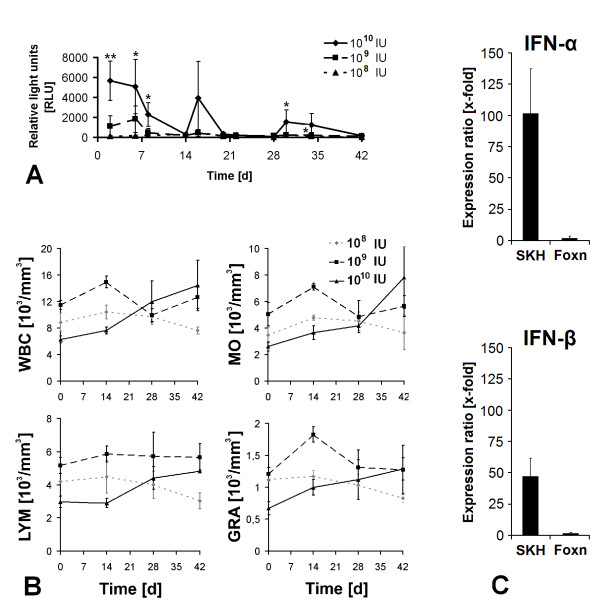
Investigation of adenovirus induced immune reaction in vivo. (A) Quantitative GFP fluorescence and (B) numbers of leucocytes (WBC), granulocytes (GRA), lymphocytes (LYM) and monocytes (MO) in immunocompetent, hairless mice (SKH-1h/r) at timepoints of 14, 28 and 42 days after intradermal injection of 108 - 1010 IU Ad-GFP. (C) RT-PCR analysis of IFN-α and IFN-β expression 48 h after intradermal injection of 1010 IU Ad-GFP in immunocompetent (SKH) and athymic (Foxn) mice. Results were normalised to an untreated control area.